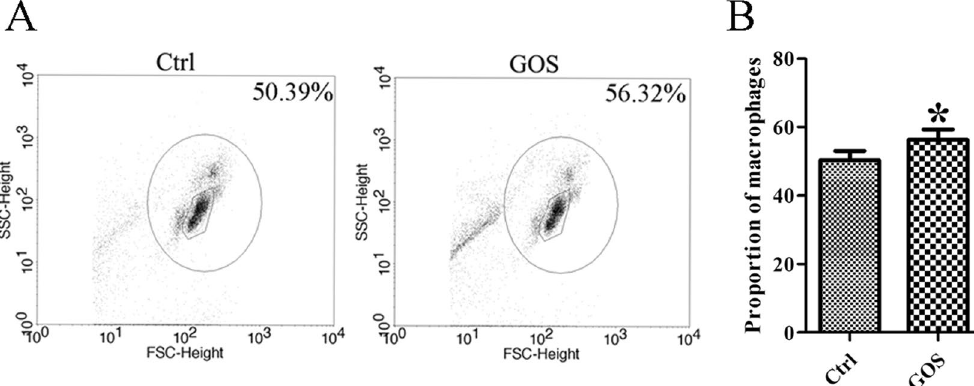
Figure 7. GOS induces macrophage proliferation in mice ascites. ( A ) Male BALB/c mice received an i.p . injection of 100 μ l PBS or GOS (2 mg/mouse) for 24 h. Peritoneal fluid cells were collected and analyzed by FACS. ( B ) Data are expressed as the percentage of total cells and represent the means ± SD ( n = 5). * P < 0.05.